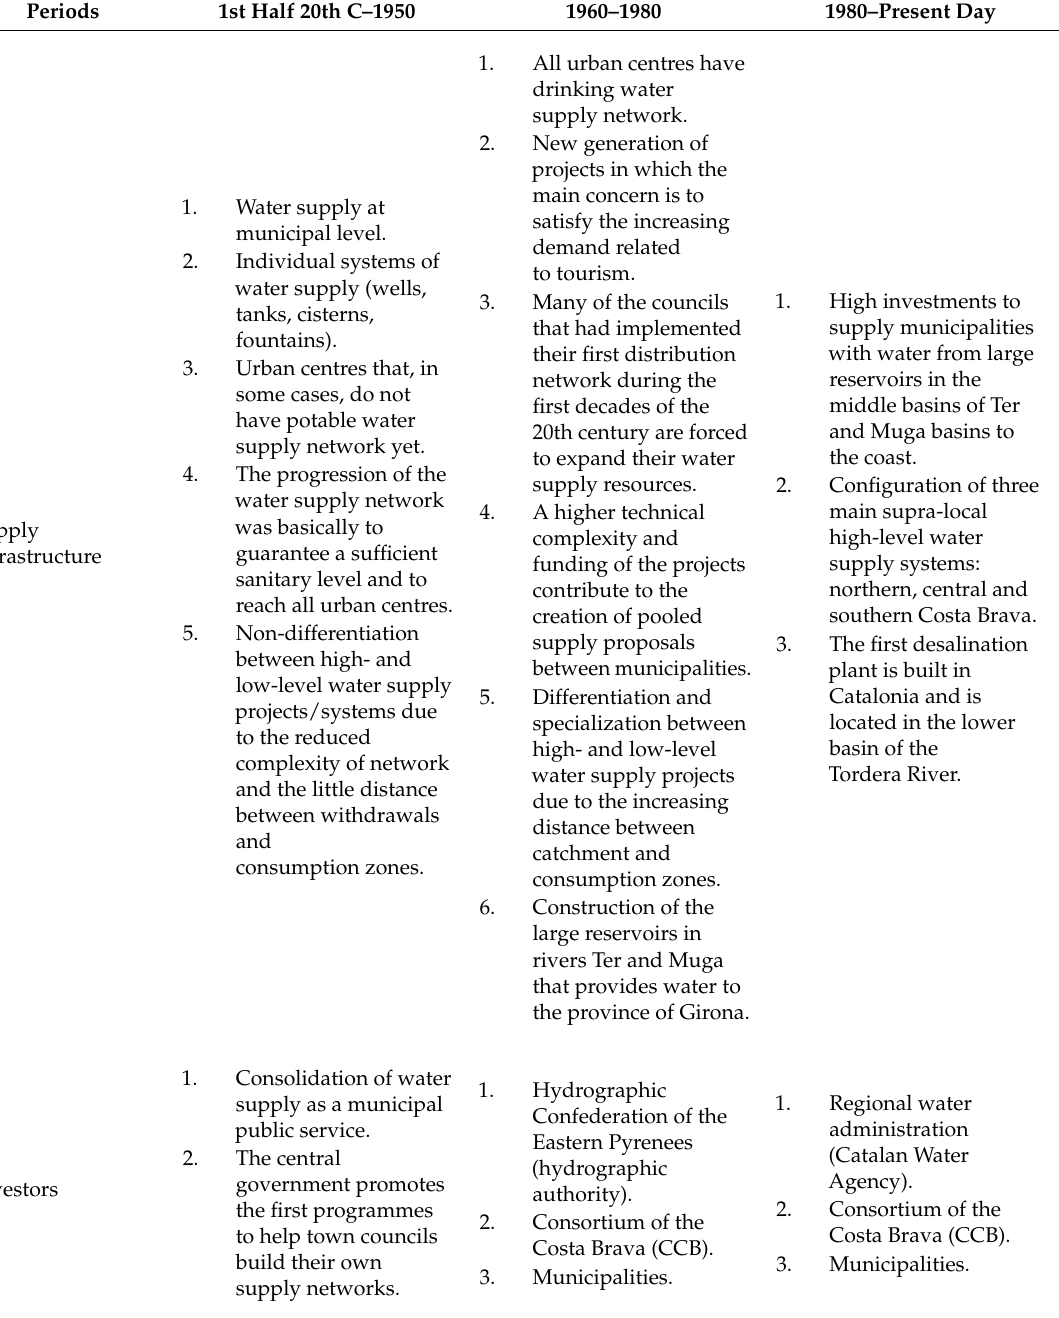
Table 2. Overview of the main characteristics of supply infrastructures, financing, administration-operation, water resource and the environment throughout the three periods analysed.